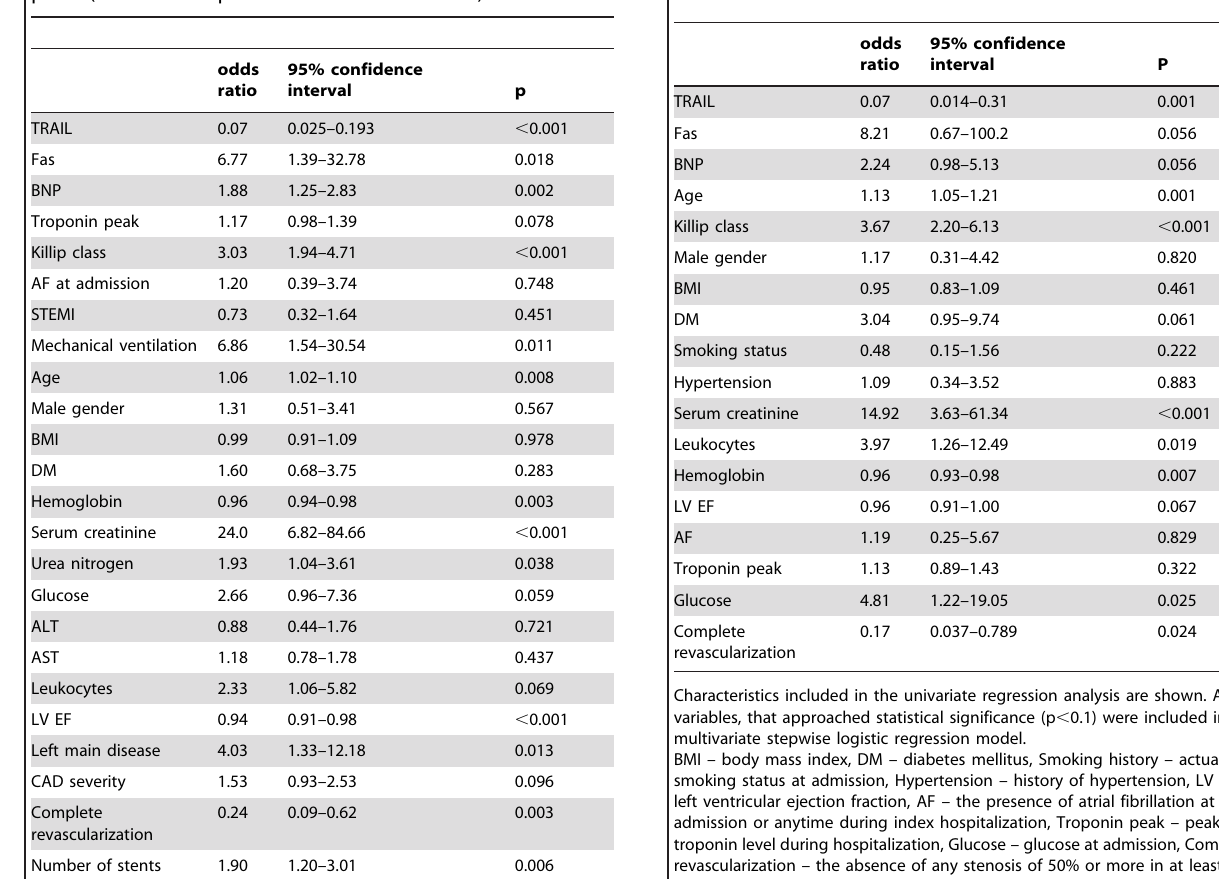
Table 3. Univariate analysis of predictors of